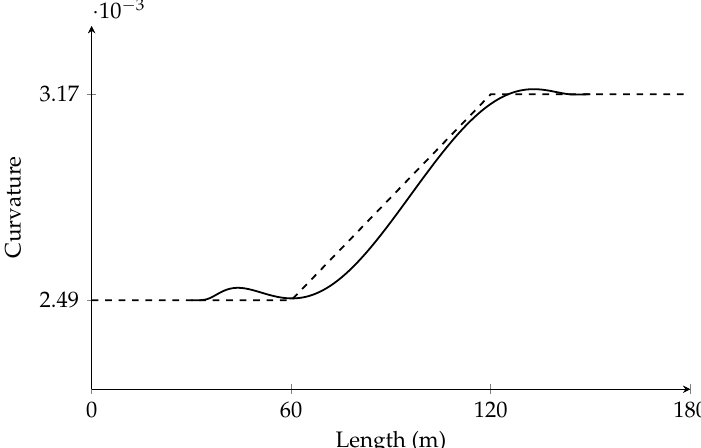
Figure 7. Curvature plots of a clothoid with parts of connected circular segments (dashed) and a blending spline, with local Bézier curves